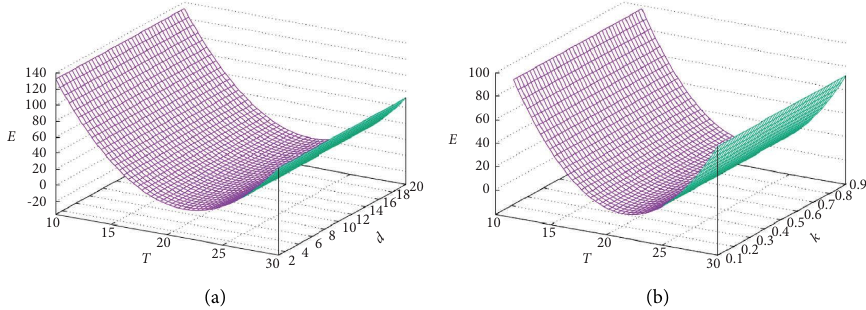
Figure 8: Dependence of the criterion on the parameters.